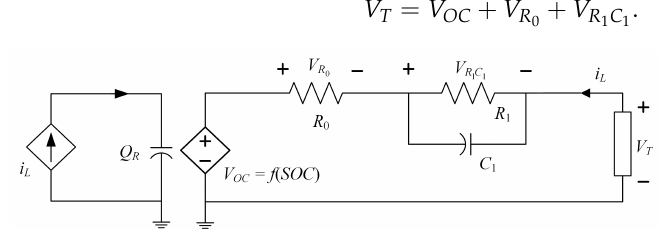
Figure 1. Battery electric circuit model. The open-circuit voltage V OC is a nonlinear function with respect to the battery